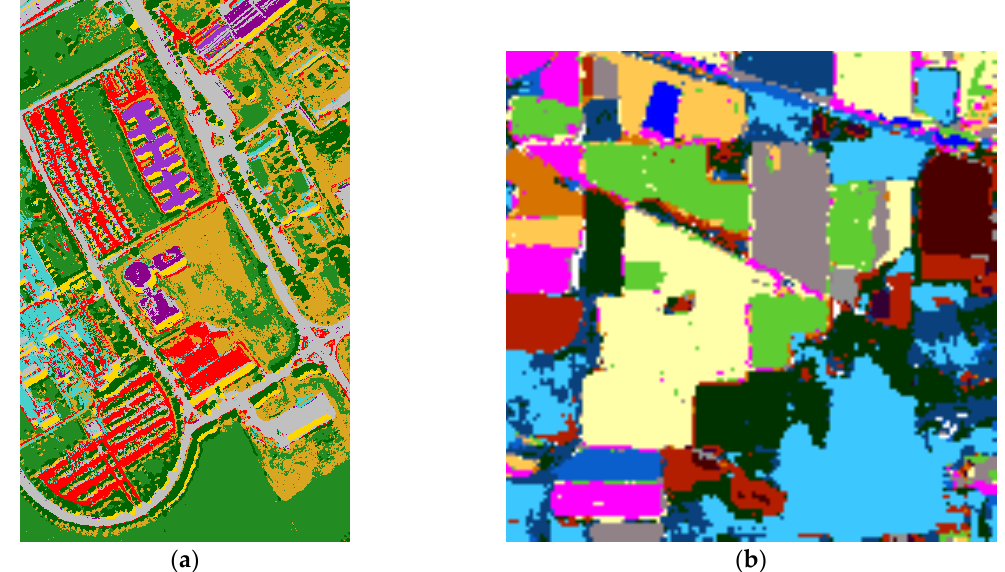
Figure 8. Joint-dominated classification result for Pavia University ( a ) and Indian Pines ( b ).